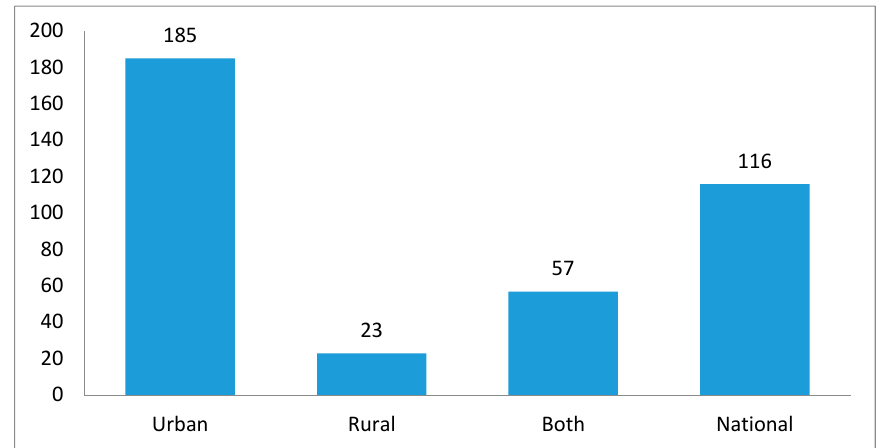
Figure 6. Representativeness of Data for Tobacco Control Research in SSA, (up to February 2017; n = 381).